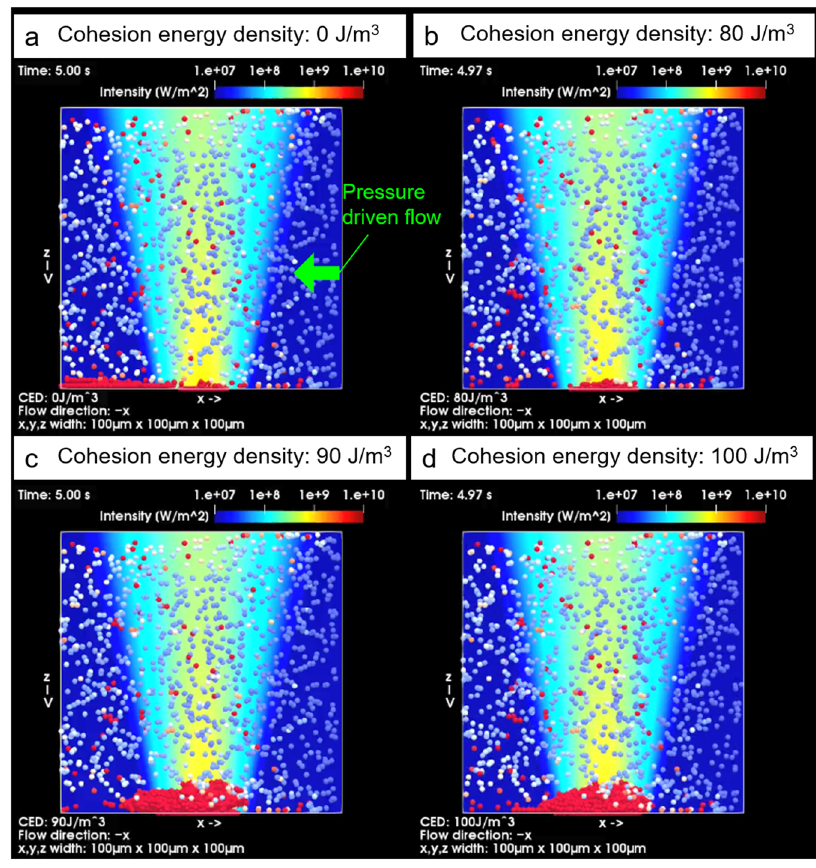
Fig. 4 Theoretical simulations of light-induced acceleration of antigen – antibody reaction in a micro fl ow. Calculated results of light-induced assembly of microparticles by optical pressure in micro fl ow channel for different cohesion energy densities between antigen and antibody on each bead assuming the different antigen concentrations (volume fl ow rate: 0.1 μ L/min, Laser power: 530 mW, laser spot was set to 65 μ m below the bottom of the channel). In each panel, cohesion energy was assumed to be a : 0 J/m 3 , b : 80 J/m 3 , c : 90 J/m 3 , d : 100 J/m 3 . The colour of the particle indicates the time elapsed since the particle appeared from the inlet (blue: 0 s, white: 1 s, red: 2 s). See also Supplementary Movies 1 and